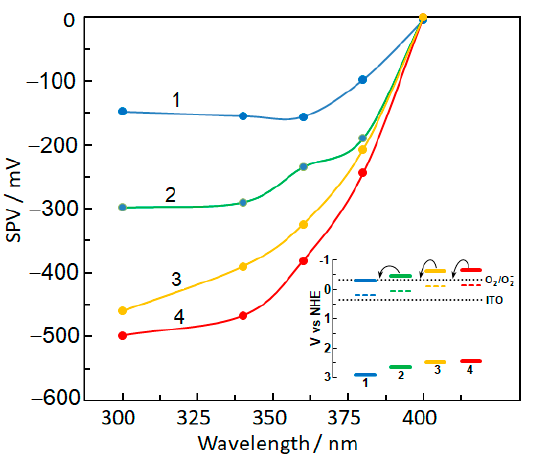
Figure 11. Surface photovoltage (SPV) spectra of pristine TiO 2 (1), Ag/TiO 2 (2), Au/TiO 2 (3), and Pt/TiO 2 (4). Inset: corresponding energy diagram at 300 nm; the dashed lines indicating the Fermi levels of samples.